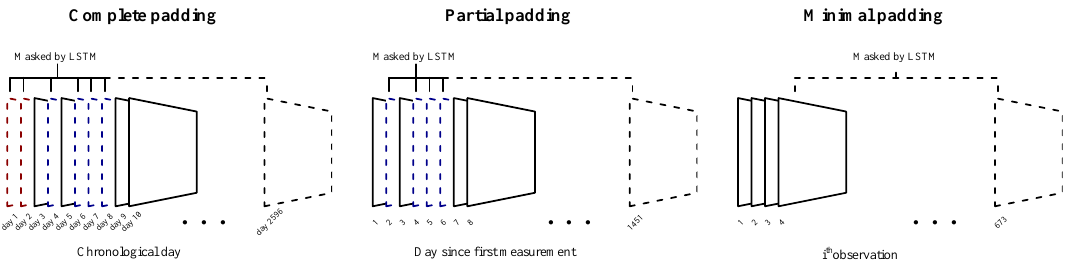
Figure 2. Example of a sequence of surveys. Dashed surveys are missing ( red : prior to first entry; blue : between entries; black : variable sequence length until the participant’s last